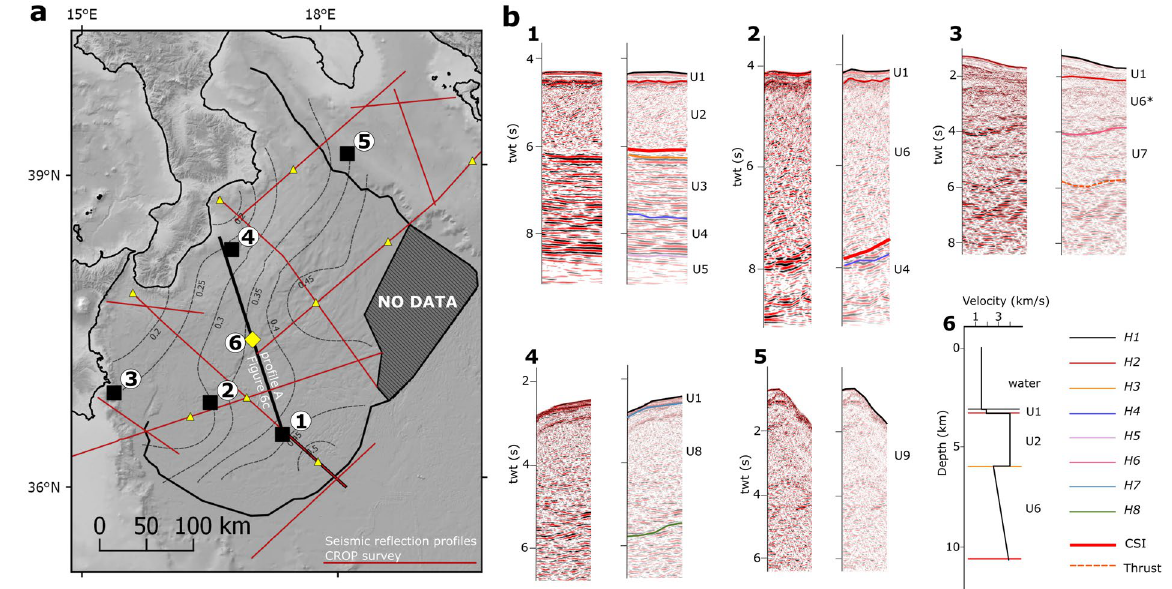
Figure 2. Seismo-stratigraphic scheme and velocity model. Panel a – Map of the sample seismo-stratigraphic logs (Panel b, #1-5) and the velocity gradient (k, labelled dashed contour lines) within U6 (Panel b, #6). The location of points used for analysis of the stacking velocities is shown by yellow triangles; the location of the sample velocity model is indicated by the yellow diamond. Panel b - Sample seismo-stratigraphic logs (#1-5) and sample velocity model (#6). Description of units (U1-9) and bounding horizons (H1-7) are reported in Tables 2 and 3, respectively. Notice that U6 * in this sample stratigraphy represents the thrust top basin sediments deposited